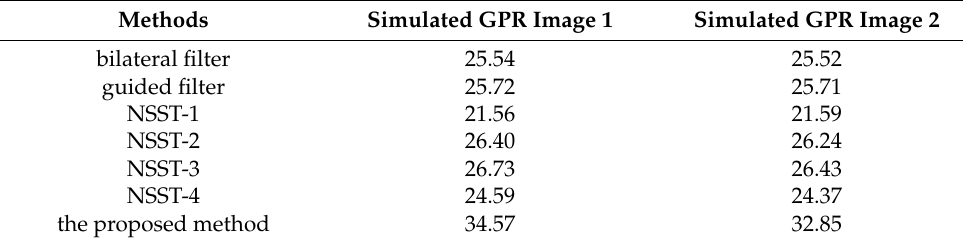
Figure 10. ( a ) The SNR results of different denoising methods for the simulated noisy GPR image 1. ( b ) The SNR results of different denoising methods for the simulated noisy GPR image 2. Table 2. PSNR results of different denoising methods.